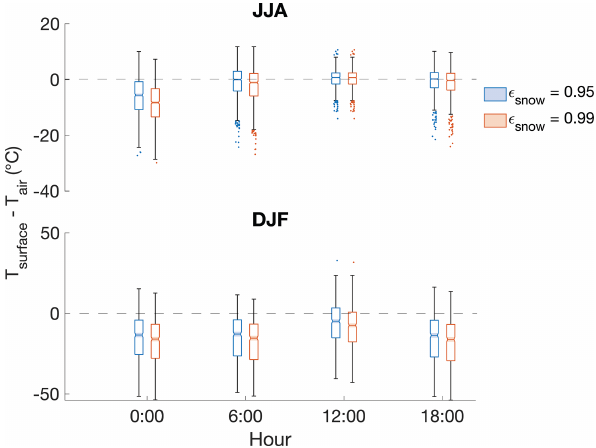
Figure 11. Diurnal differences between surface and 2m air temper- atures calculated from ERA5 and Divide AWS data. Summer (JJA) and winter (DJF) data are shown separately to control for seasonal effects. Shaded notched areas indicate the 95% confidence interval for the median temperature difference. Horizontal dashed lines indi- cate where surface temperatures and air temperatures are equivalent. All surface temperatures > 0 ◦ C were assigned a value of 0 ◦ C.